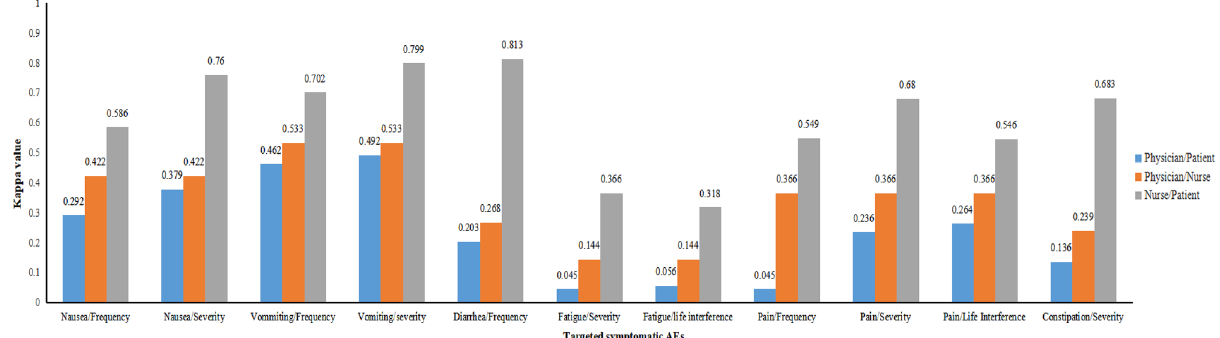
Figure 1. Consistency analysis of symptomatic AEs reporting rate among nurses, physicians, and patients. k < 0.000 Poor agreement; 0.000 ≤ k ≤ 0.200 Slight agreement; 0.210 ≤ k ≤ 0.400 Fair agreement; 0.410 ≤ k ≤ 0.600